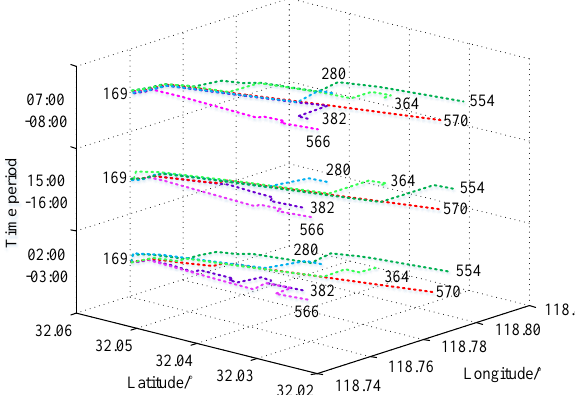
Figure 7. Actual route under peak, flat hump and off-peak time periods.